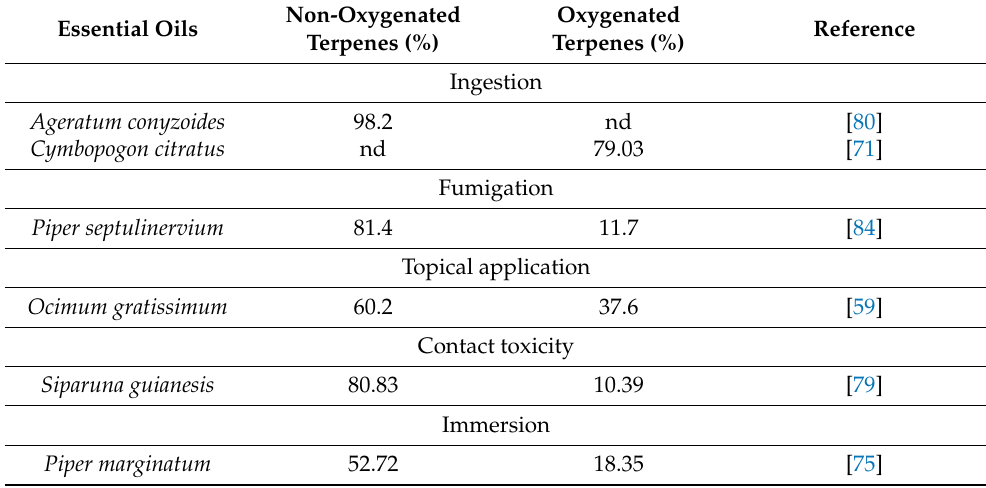
Table 12. Percentage composition of oxygenated and non-oxygenated terpenes of the most toxic EOs for Spodoptera frugiperda